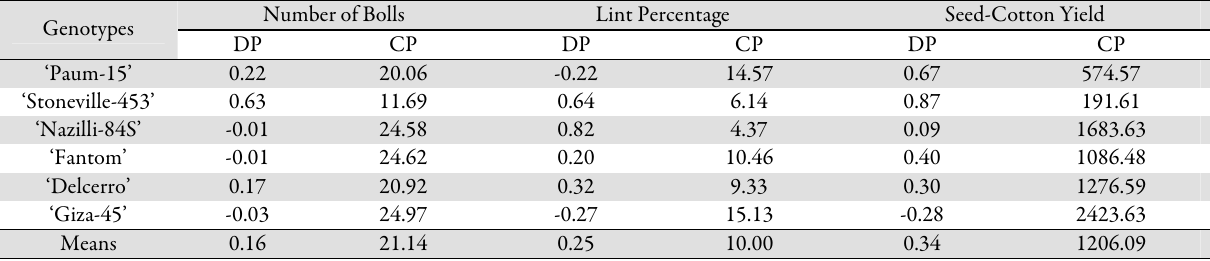
Table 6. Closest position to the origin and dominance proportion of different parents for investigated traits in a 6x6 F 1 diallel